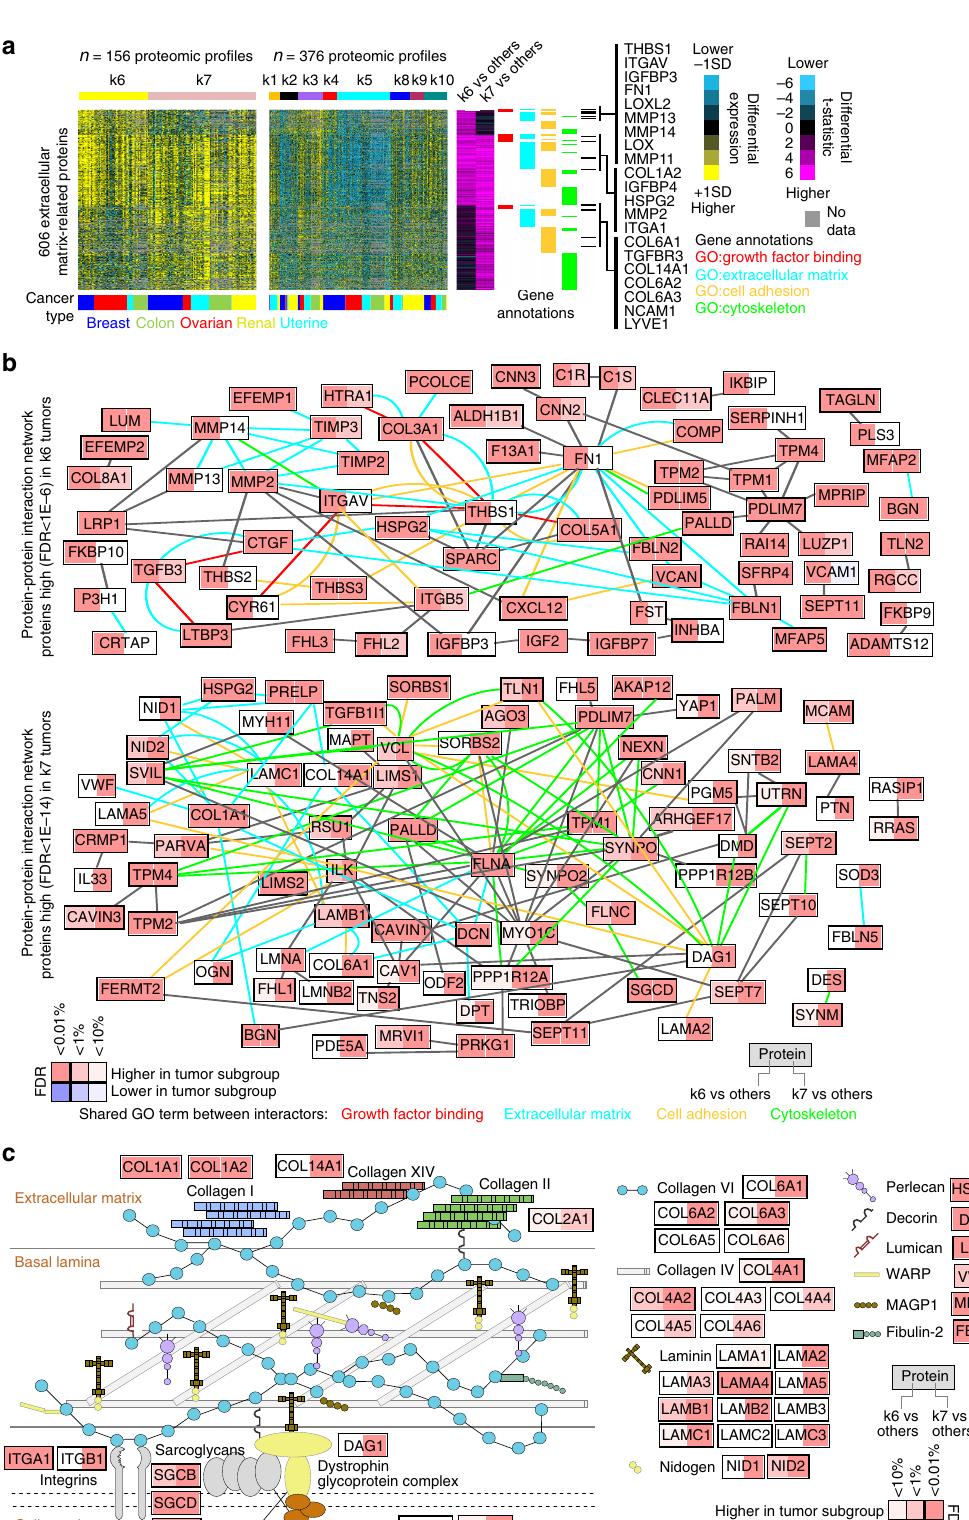
Higher in tumor subgroup Lower in tumor